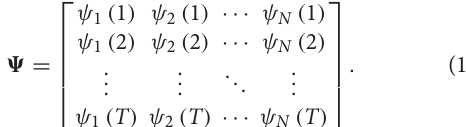
Figure 3 exemplifies the time-alignment of multiple trajectories.